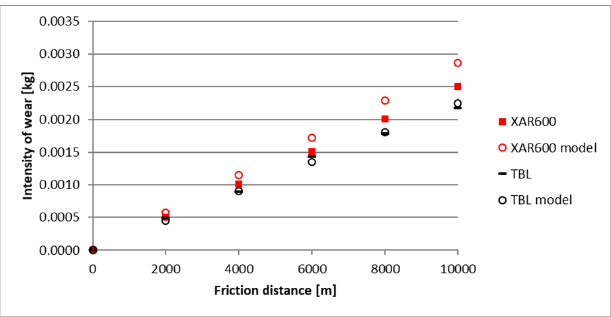
Figure 9. The course of theoretical and empirical wear of B27 and Hardox 500 steels in light soil.